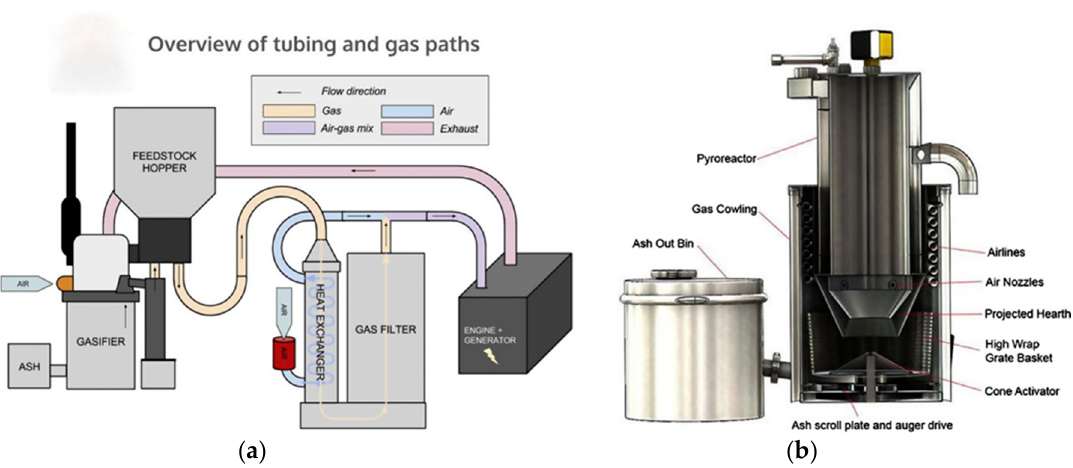
Figure 2. Scheme of operation of the system and detail of the reactor. ( a ) General description of gas pipes and routes. ( b ) Details of the gas samples’ extraction site of the Valoriza—Polytechnic Institute of Portalegre reactor exit (Portugal). (Source: Power Pallet technician manual (PP20/v1.09) and own elaboration.